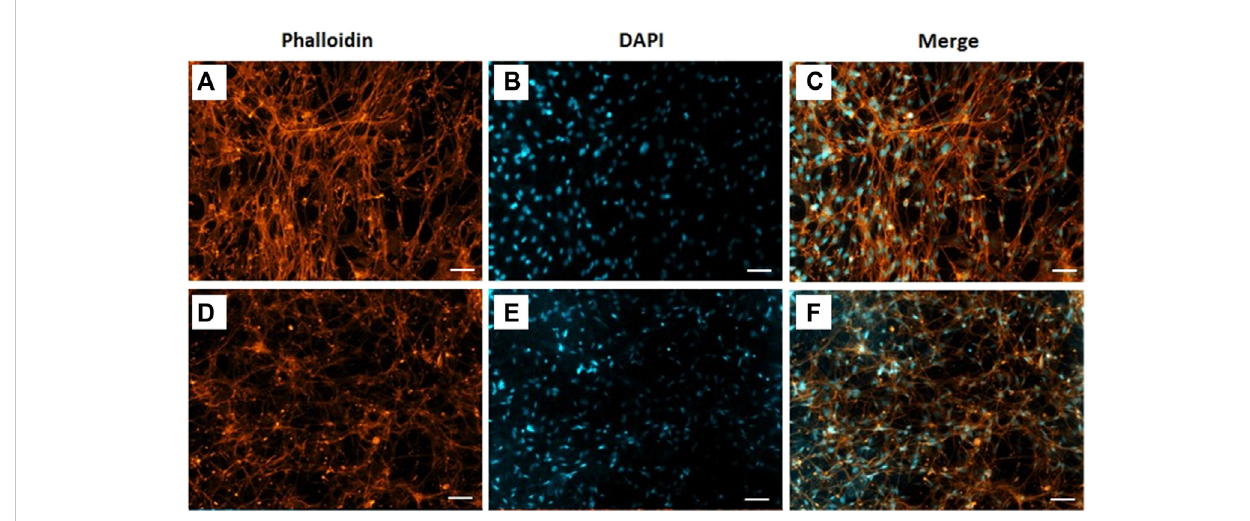
FIGURE 6 PhalloidinlabelledF-actin(orange),DAPInuclearstaining(blue)andoverlaid fl uorescentimageofC2C12cellularcomponents(merged)forCA (A,B, C) and CA@A (D, E, F) . Scale bar = 50 µm.